Question: Provide a one-line summary of what is displayed.
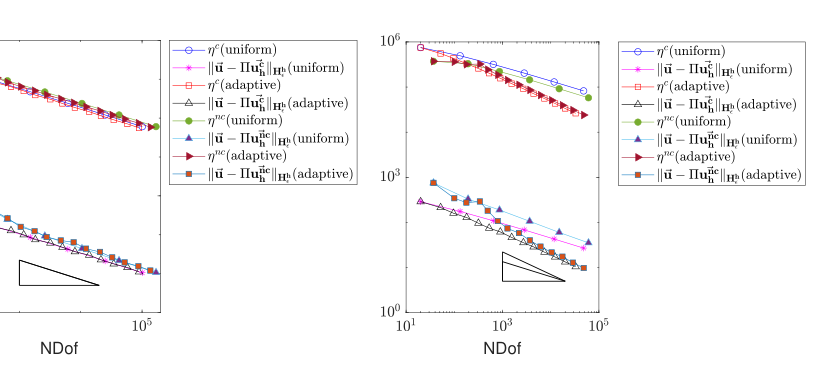
Answer: Left (resp. right) panel displays NDof vs error in en- ergy norm and estimator in both uniform and adaptive reﬁnements and both conforming and for nonconforming VEM in Example 1 (resp. Example 2). The superscript c (resp. nc) denotes the re- spect term in the conforming (resp. nonconforming) case. The triangle in left (resp. right) panel represents slope 0.5 (resp. 0.33 and 0.5).